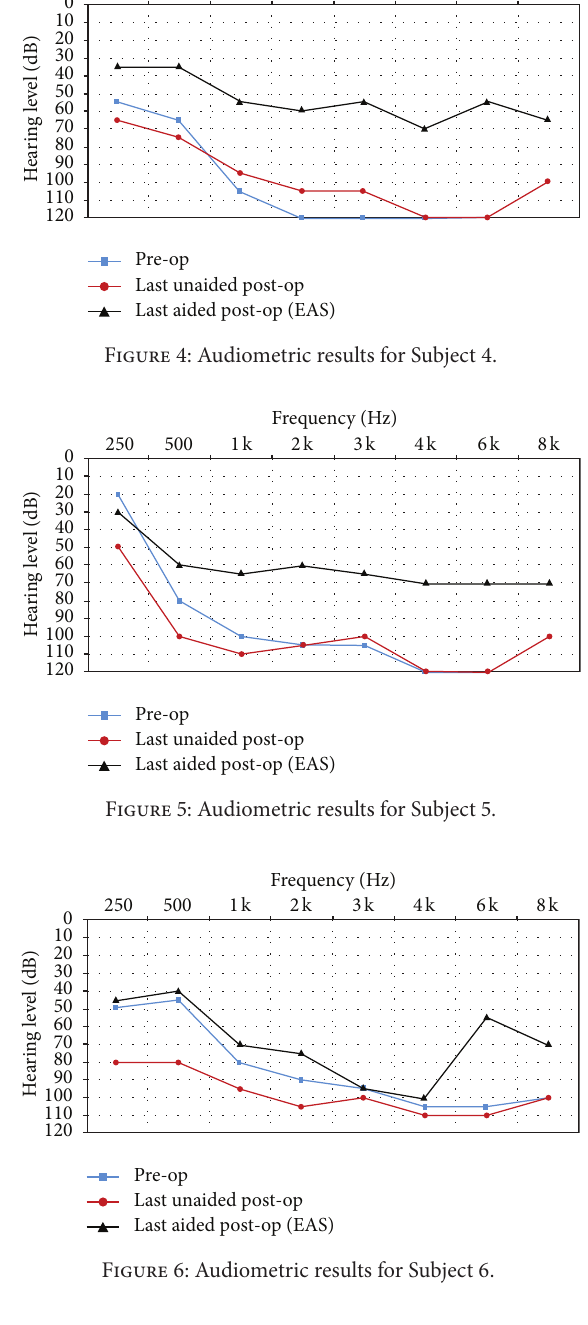
(17) positioning the ground electrode under the muscle- periosteum flap; (18) closure with Vicryl 3.0 sutures on the Palva flap planes and subcutaneous tissue; skin closure with Nylon 4.0; (19) cleaning of the patient and placing an external com- pressive dressing; (20) impedance testing, neural response telemetry (NRT), confirm the position of the intracochlear electrode.